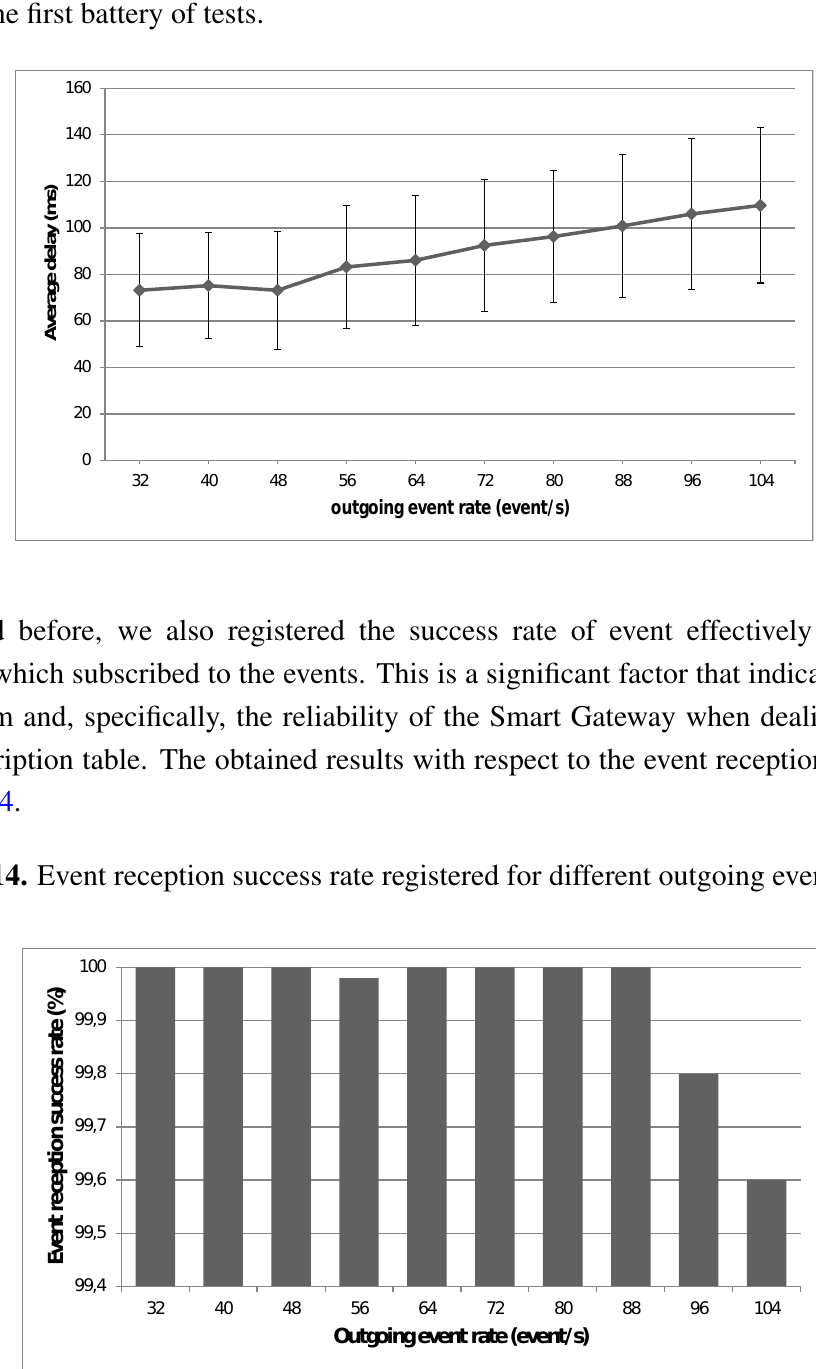
Figure 13. Average value and standard deviation of the delay registered for each of the 10 tests in the first battery of tests.